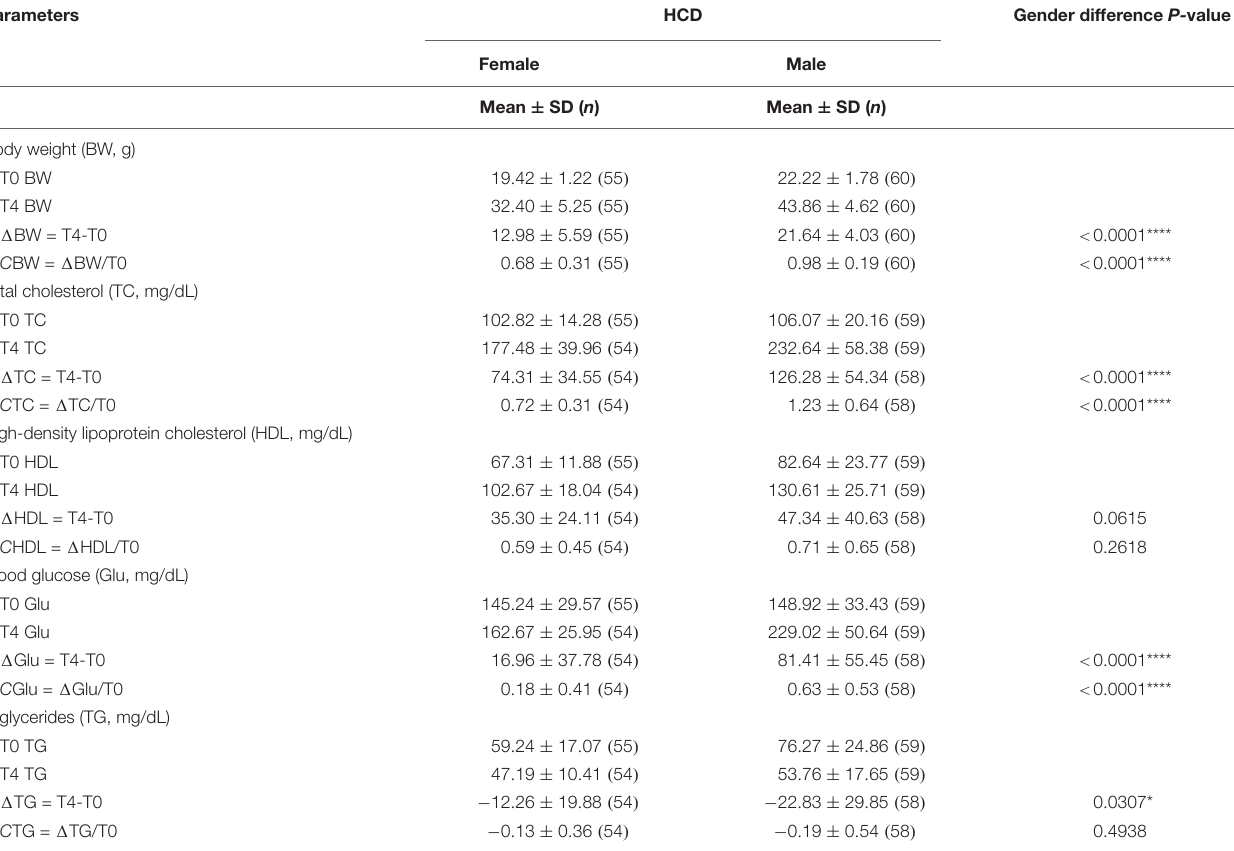
TABLE 2 | Mean absolute and relative changes in body weight and biochemical parameters among C57BL/6 mice after 4 months on HCD, by gender.